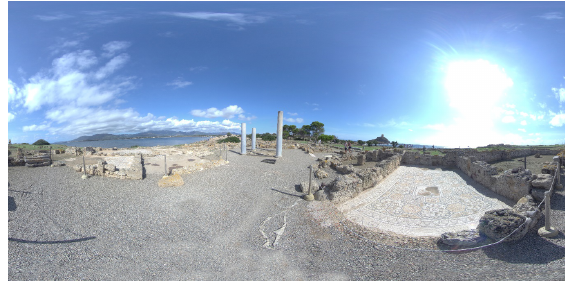
Figure 7. Panoramic view of the archaeological site of Nora.